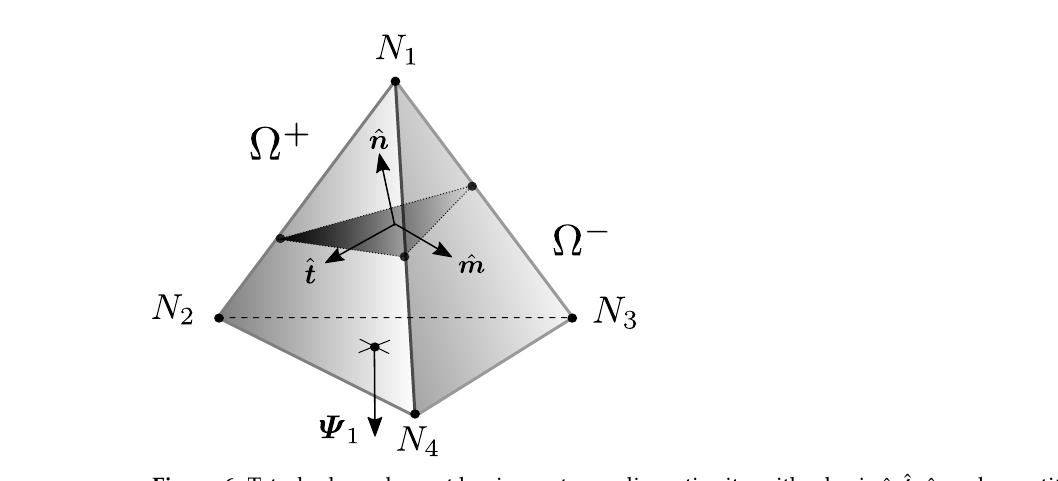
Figure 6. Tetrahedron element having a strong discontinuity with a basis ˆ n , ˆ t , ˆ m and a partition 3-1, node 1 located on Ω +